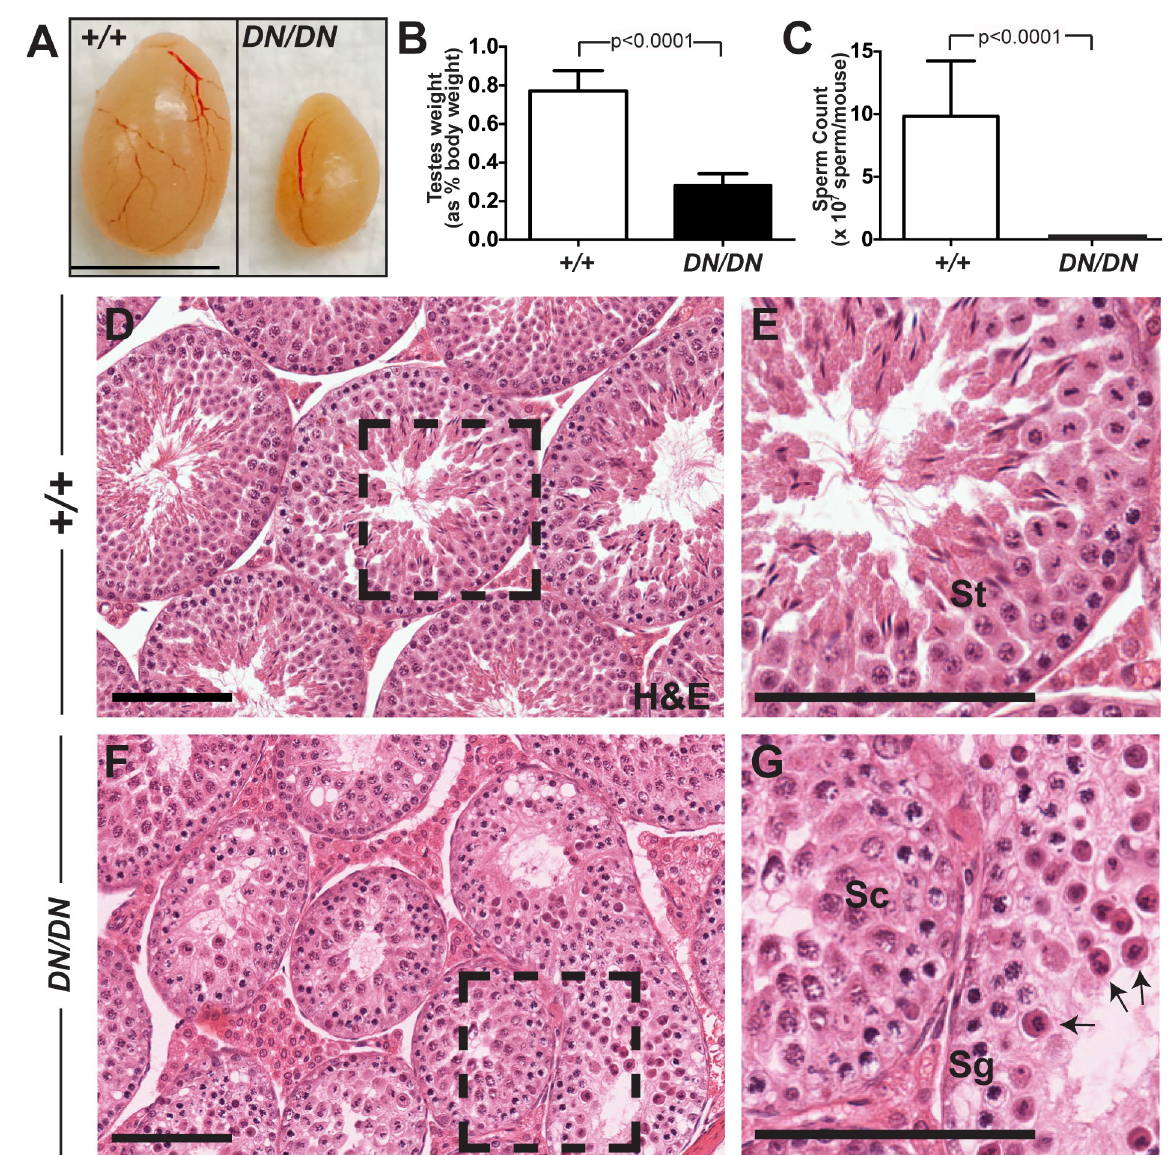
Fig 1. Mlh3 DN/DN males show a sterile phenotype. (A, B) Mlh3 DN/DN adult male testes are significantly smaller when compared to WT littermates ( Mlh3 DN/DN —0.28% of total body weight ± 0.06 standard deviation (s.d.), n = 13; WT—0.77% ± 0.1, n = 15; p < 0.0001, unpaired t- test with Welch’s correction) and (C) have zero sperm in the epididymis (WT—9.8 x 10 7 ± 4.4 sperm/mouse; p < 0.0001; unpaired t-test with Welch’s correction, n = 10 and 12 mice, respectively; error bars show standard deviation). Hemotoxylin and eosin stained (D, E) WT testes show the presence of meiotic and post-meiotic cells whereas (F, G) Mlh3 DN/DN are absent of spermatids and spermatozoa. Higher magnification of WT and Mlh3 DN/DN testes sections are shown in E and G, respectively. Black arrows in (G) indicate metaphase I spermatocytes in the Mlh3 DN/DN seminiferous tubule lumen. Sg, spermatogonia; Sc, prophase I spermatocytes; St, postmeiotic spermatids. Scale bar is 100 μ m. Images were taken at 40X magnification. Similar to the situation seen for Mlh3 -/- males [29], Mlh3 DN/DN males show complete infer- tility, accompanied by significantly reduced testes size when compared to WT (Fig 1A and 1B; p < 0.0001) and the absence of spermatozoa in the epididymides (Fig 1C; p < 0.0001). Whereas histological cross-sections of testes stained with hemotoxylin and eosin from WT males showed the presence of meiotic and post-meiotic cells within the seminiferous